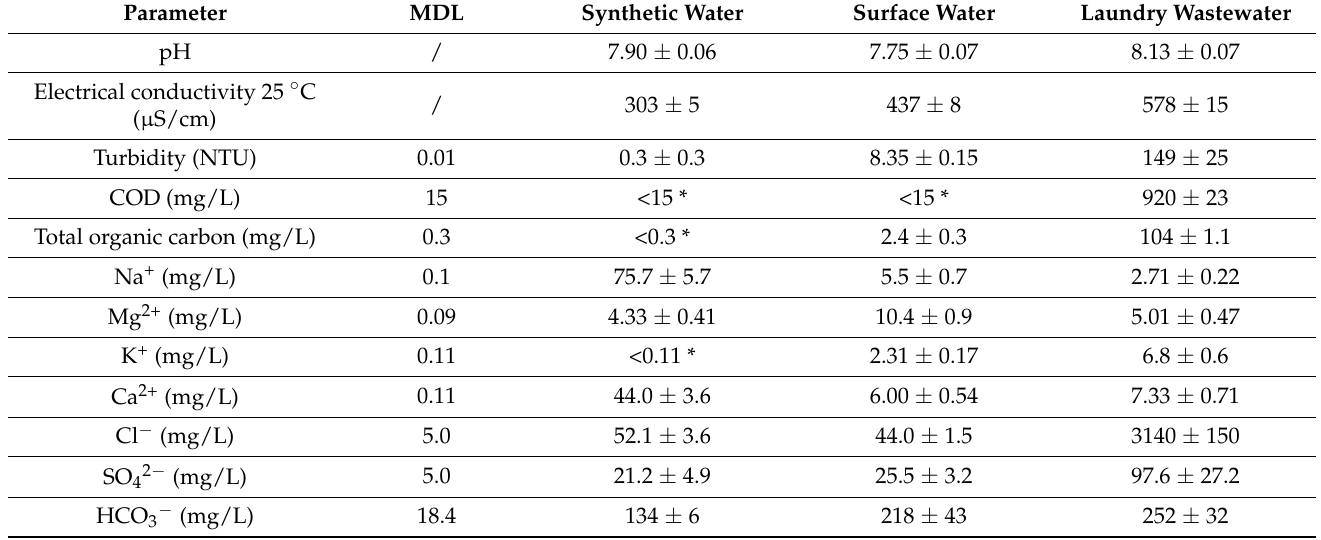
Table 1. Characteristics of the water